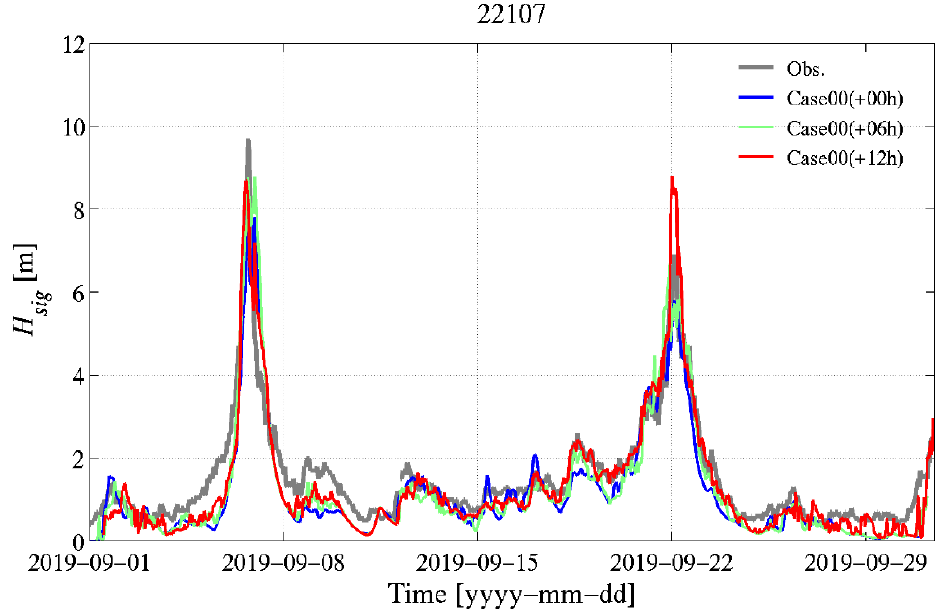
Figure 7. Comparison of the observed and simulated significant wave heights for each forecast lead time at the observation point of 22107.